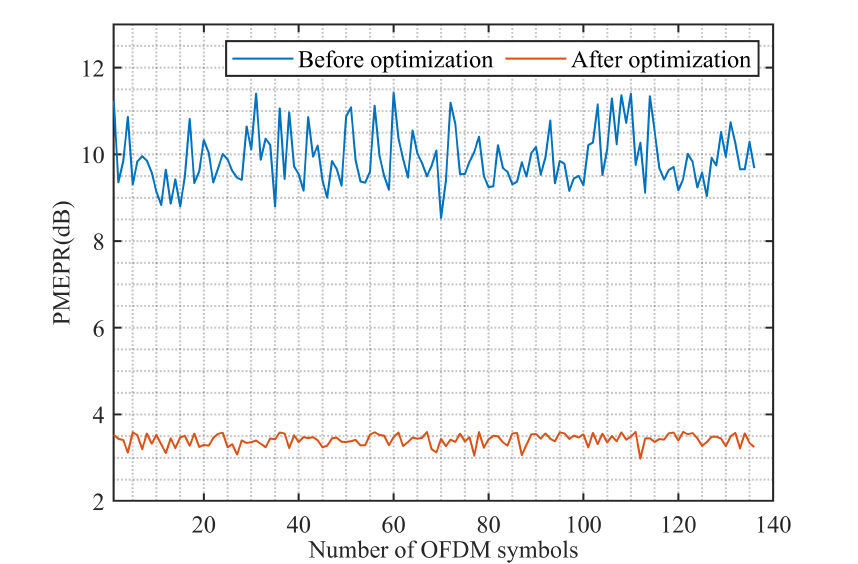
Figure 7. PMEPRs of different OFDM symbols before and after PMEPR